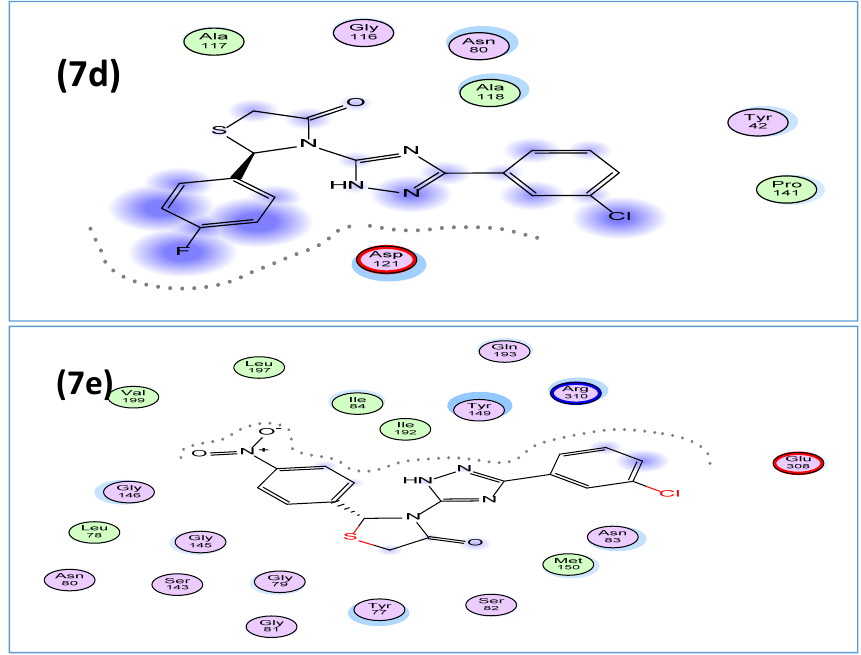
Figure 7. 2D binding mode interaction and residues involved in the recognition of the non-active Compounds 7d and 7e , into the MurB binding site.